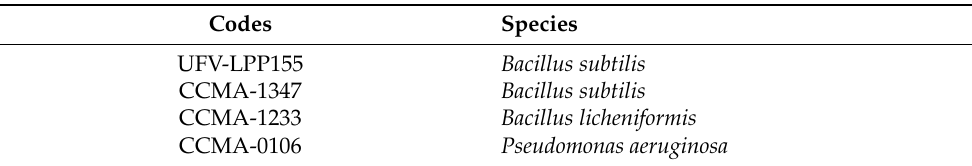
Table 1. Pre-selected microorganisms to evaluate the potential for biocontrol and growth-promotion